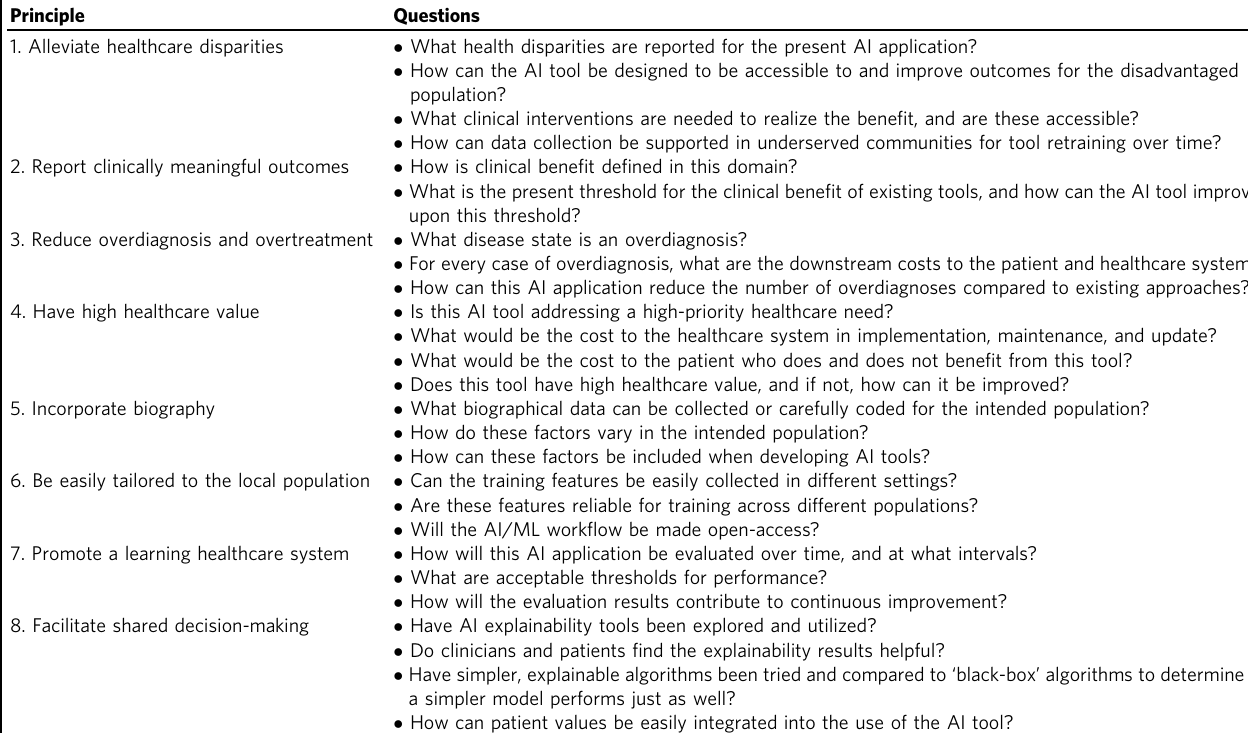
Table 2 Questions that can be used when considering each principle in the AI development